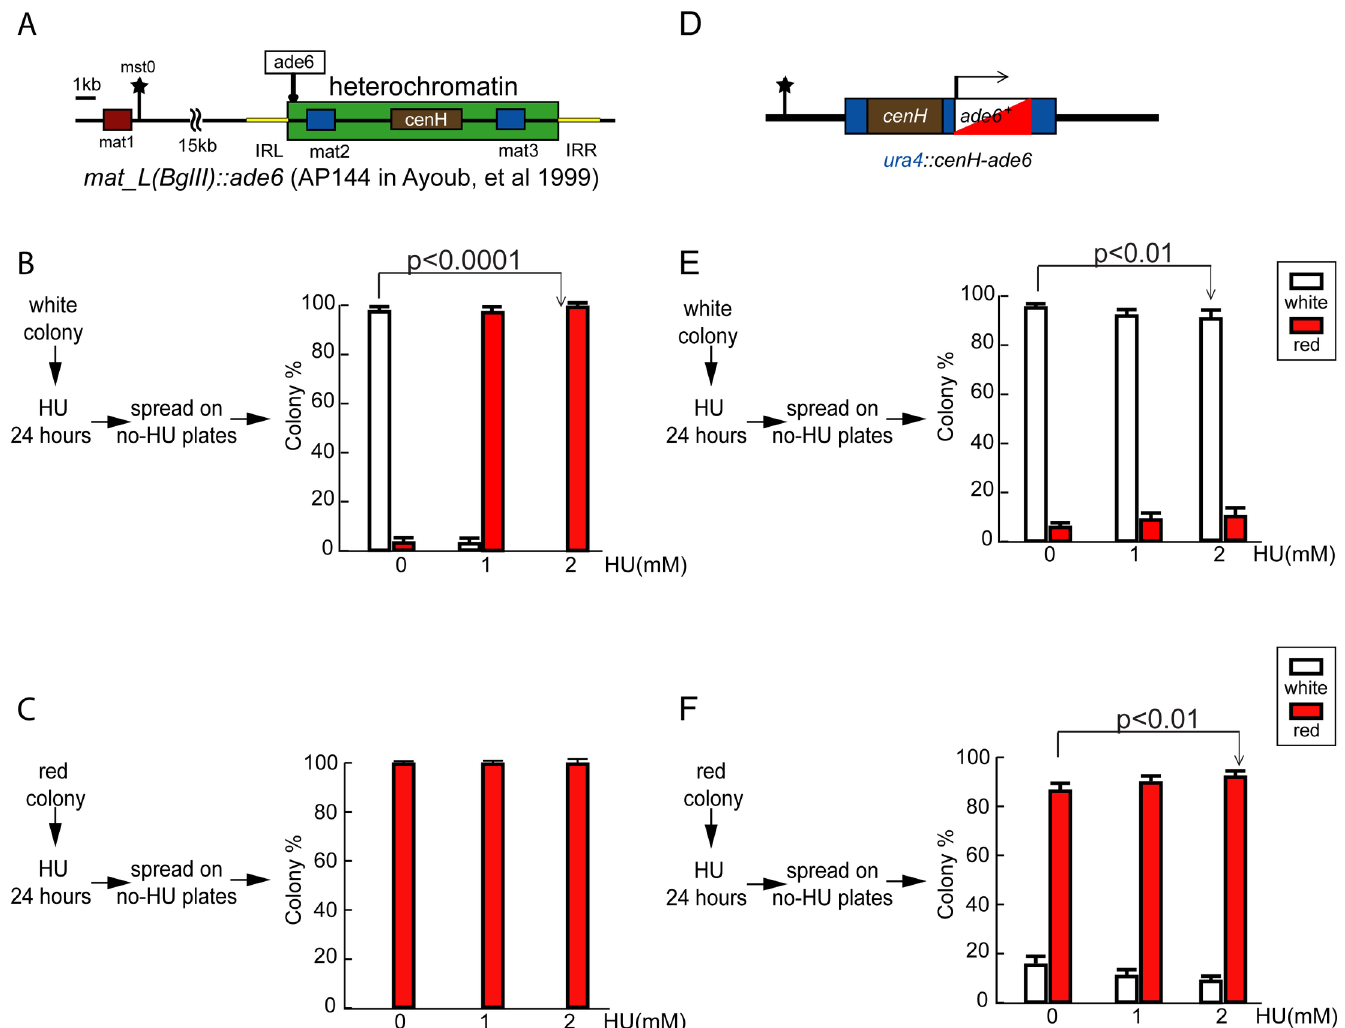
Fig 4. HU affectsPEV at heterochromatin region. (A) HU affects PEV within the mating type locus. Diagramillustrates the location of ade6 + insertion at the mating type locus, betweenthe centromere-proximalboundaryand the mat2-P gene (strain AP144— mat_L(BglII) :: ade6 + ). Dark green box indicatesa normalsilencingdomain. (D) HU treatment affects PEV inducedby cenH at an ectopic site. Diagramillustrates the genetic construct of the strain (LW75- cenH- ade6 + ). cenH and ade6 + are insertedin the ura4 + locus, replacingthe majority of the ura4 + ORF. (B-C, E-F) For each strain, cell suspensionsof a predominantly white colony (B, E) and red colony (C, F) are treated with HU as labeledfor 24 hours, washed and plated onto YE+4S solid media, and incubatedat 25 ˚ C for 5 days. The red and white coloniesare counted respectively, with 300–400total/per plate. The error bars are 1 SD of percentages for four plates. p values are calculatedby Fisher exact